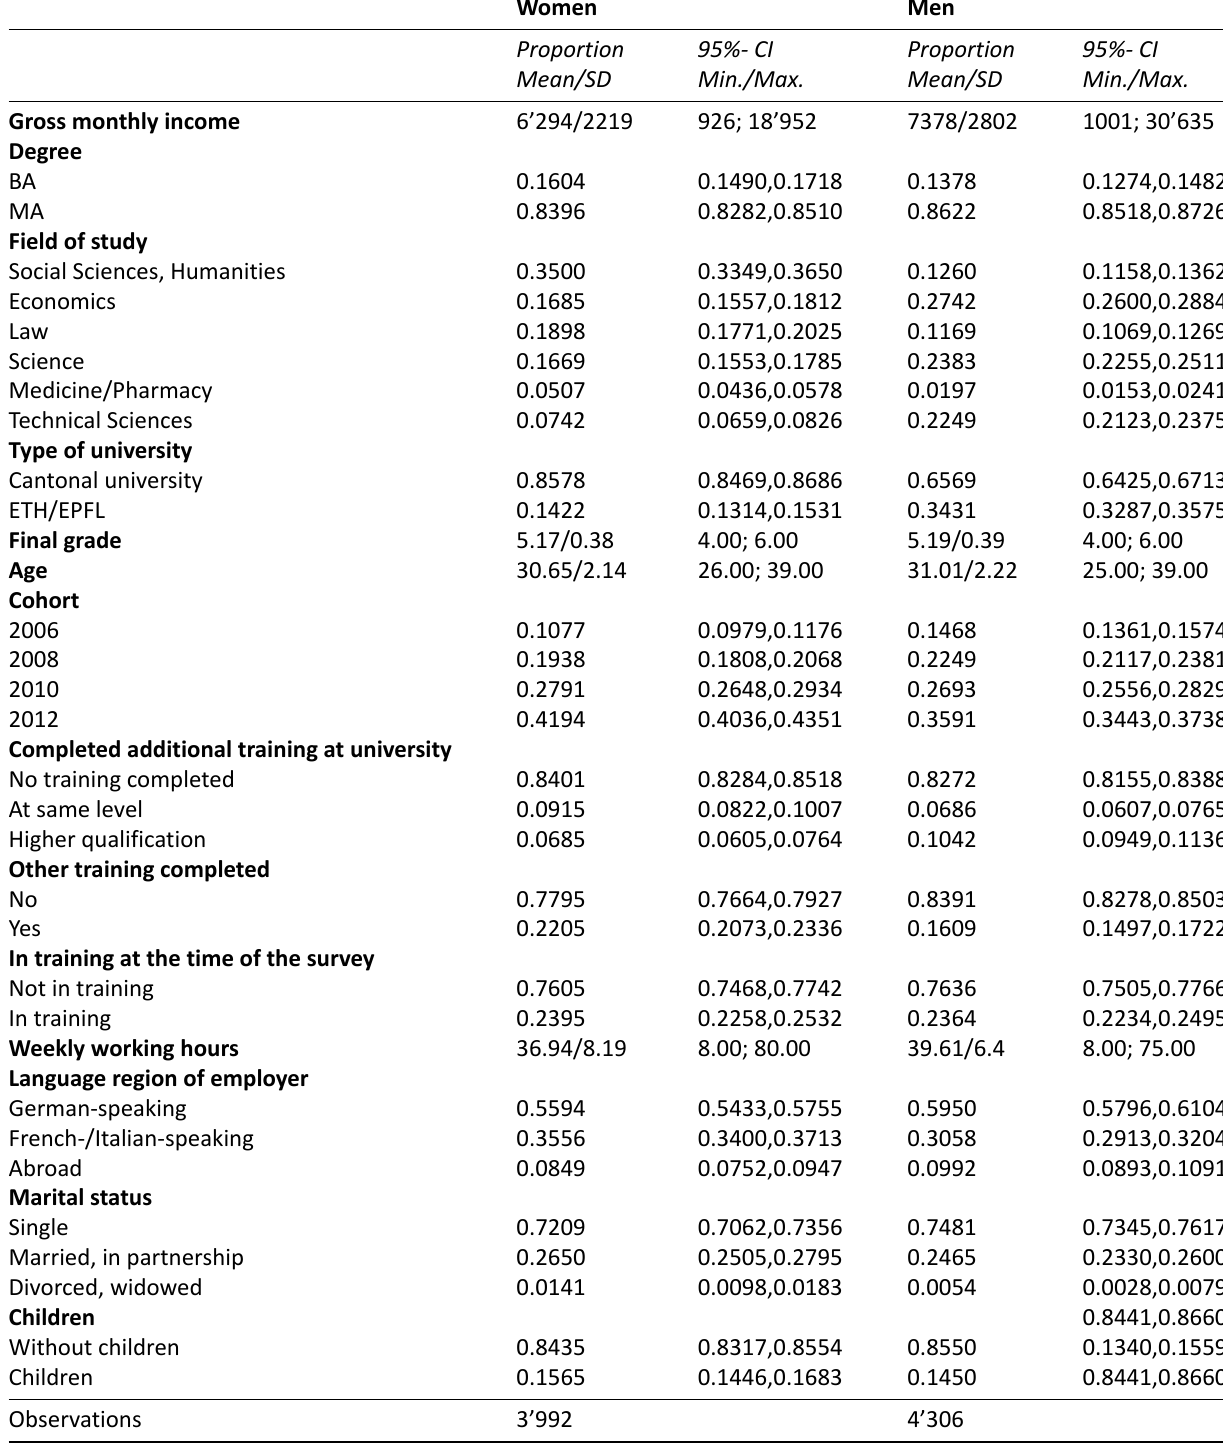
Table A2. Descriptive statistics: Fifth year after